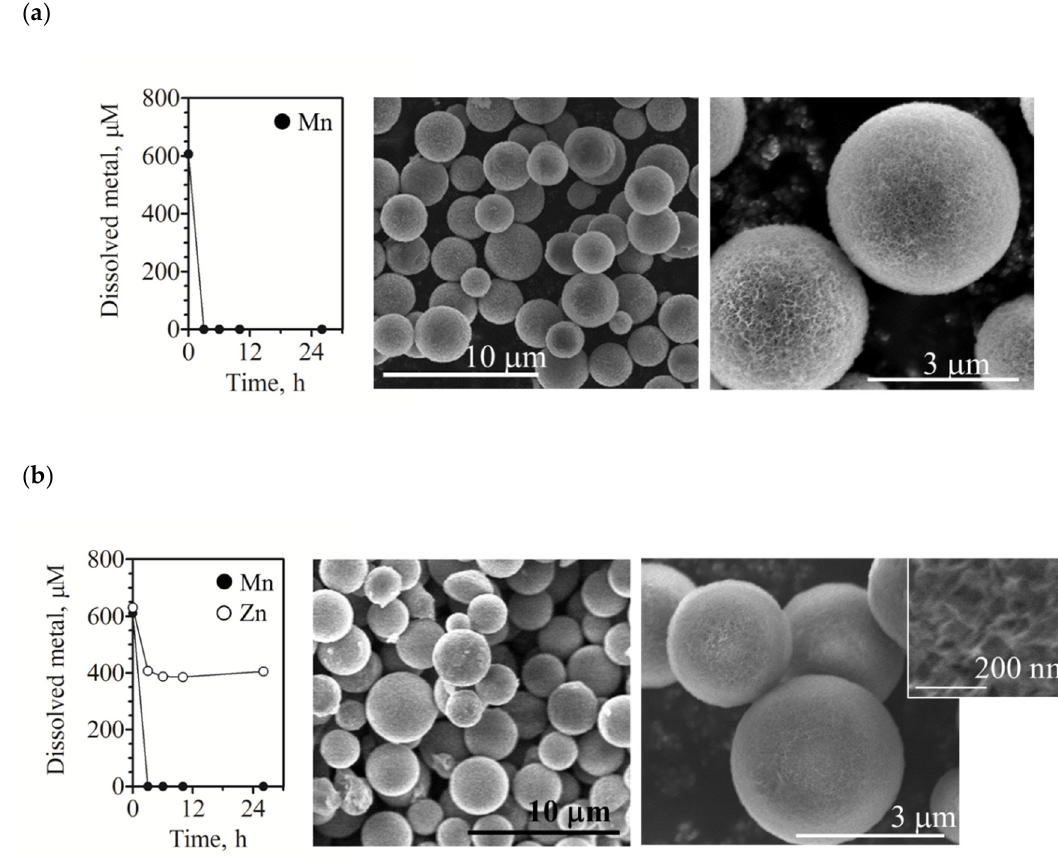
Figure 4. Mn(II) oxidation by recombinant A. strictum KR21-2 Mco1 and SEM images of solid-phase Mn produced by the enzyme reaction. ( a ) Precipitation of dissolved Mn(II) during the enzyme reaction without ZnSO 4 ; ( b ) Precipitation of dissolved Zn(II) along with Mn(II) during the reaction in the presence of ZnSO 4 . The data of metal concentrations represent mean ± SD from duplicate runs; error bars are smaller than the symbols. The SEM images display the formation of spherical Mn oxide particles with fine-crumpled surfaces, which were collected after 26 h of incubation.